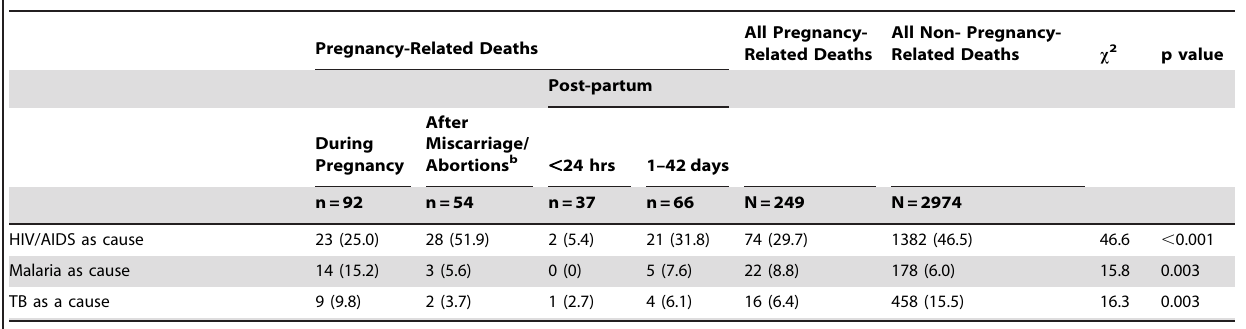
Pregnancy-Related Deaths